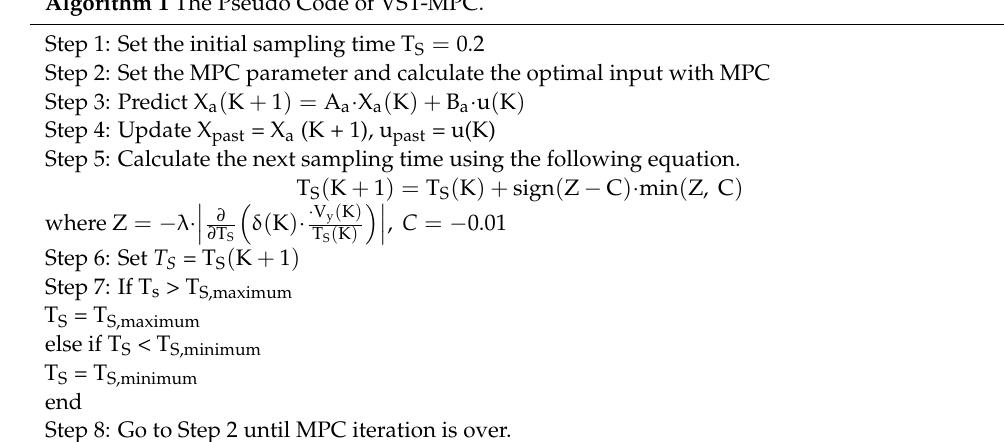
Algorithm 1 The Pseudo Code of